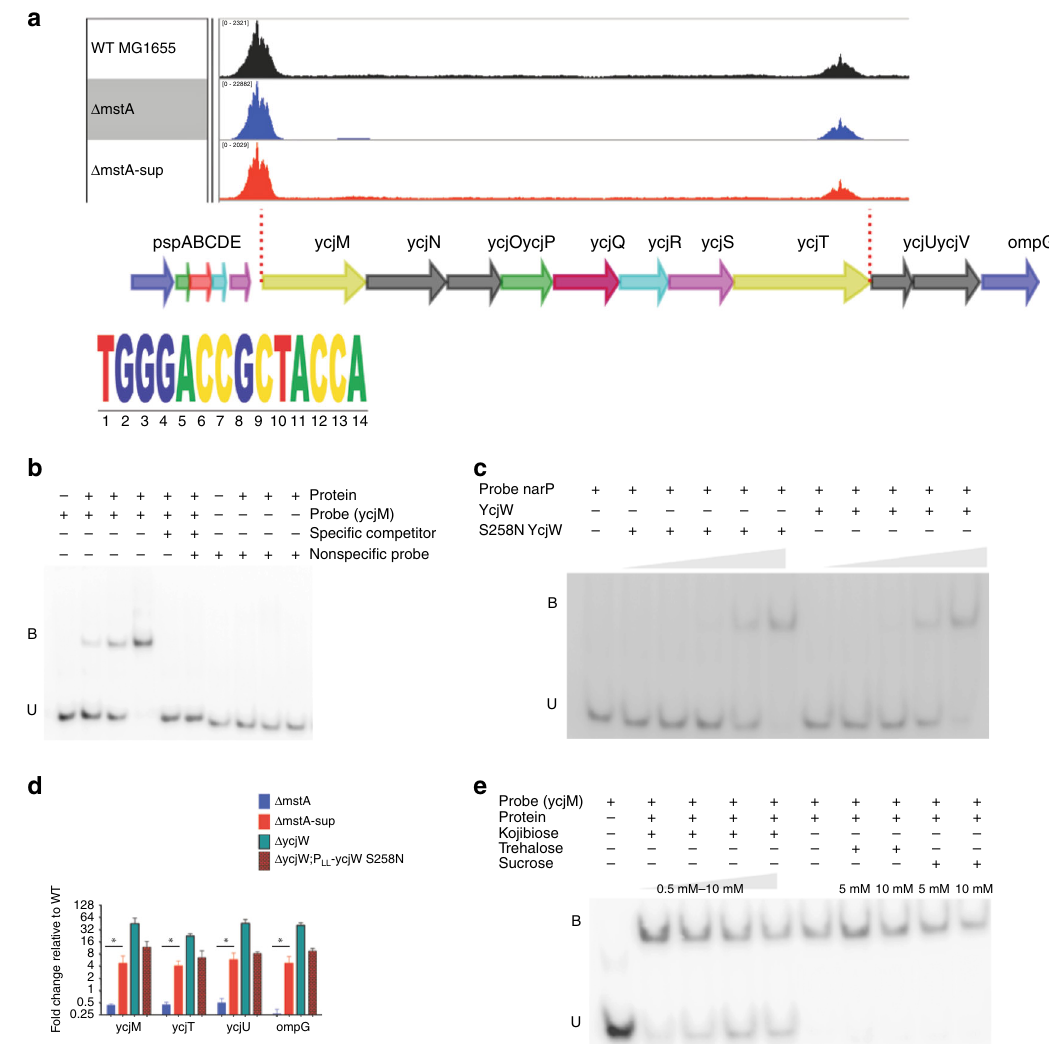
Fig. 3 YcjW shows binding enrichment near ycjM and ycjU and regulates expression of operon ycjMNOPQRSTUV-ompG . a Represented on Integrative Genomics Viewer (IGV), are sorted, aligned sequences containing pileup data to reference genome NC_000913.3. MACS2 was used for peak calling. Enriched peaks are upstream of ycjM and ycjU . A 14 nucleootide sequence identi fi ed as the binding motif for YcjW. b YcjW protein was titrated to DNA: protein ratios of 1:0.5, 1:1, and 1:2. Unlabeled ycjM probe was added to the reaction in excess to compete for binding. Unbound (free) probe and YcjW- probe complexes are denoted as U and B, respectively. c YcjW and S258N YcjW proteins were titrated to DNA:protein ratios of 1:0.125, 1:0.25, 1:0.5, 1:1, and 1:2. with narP probe. Unbound (free) probe and YcjW-probe complexes are denoted as U and B, respectively. d qRT-PCR of a subset of genes in the ycjM- V and ompG operon. The absence of ycjW results in massive upregulation. mstA-sup and ycjW; P fi cant LL — ycjW both showed moderate and signi increased expression, while mRNA levels are repressed in mstA . Values are means ± SD ( n = 3). * p < 0.05 as determined by the Student's t test. e YcjW protein was pre-incubated with Kojibiose, trehalose, or sucrose before radiolabeld DNA probes were added to the mixture. Only kojibiose prevented complex formation at a concentration of 0.5 mM. In contrast, both sucrose and trehalose added in excess at 5 mM and 10 mM failed to disrupt binding. Unbound (free) probe and YcjW-probe complexes are denoted as U and B, respectively. Source data are provided as a Source Data fi